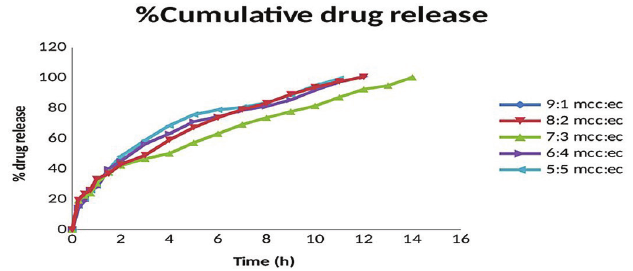
FIGURE 2 - Images of optimized batch (P17) of methotrexate core pellets.